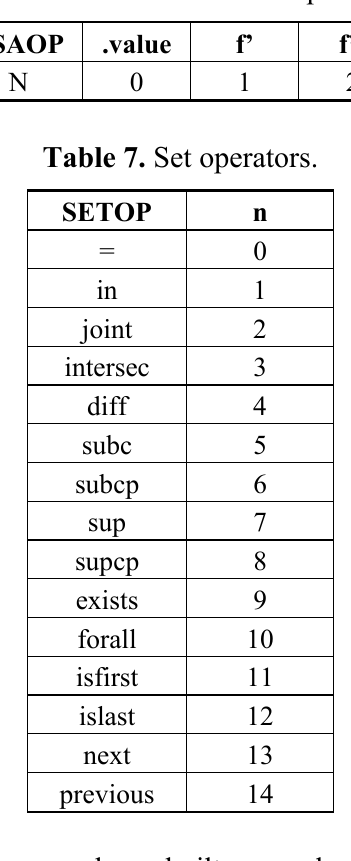
Table 6. Time series access operators.